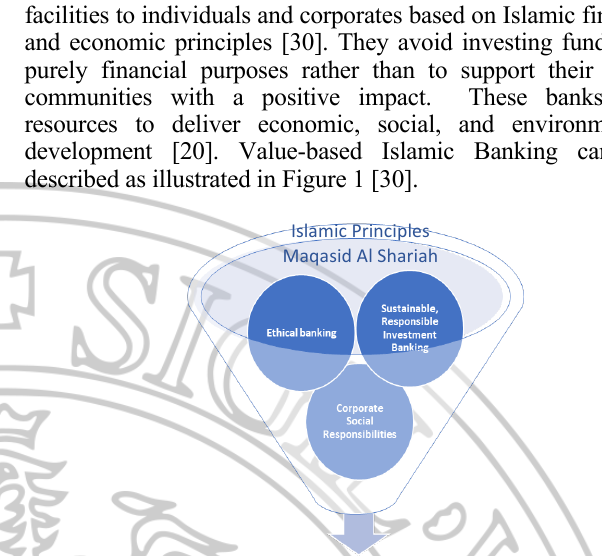
Figure 1. The concept of value-based Islamic banking [30]